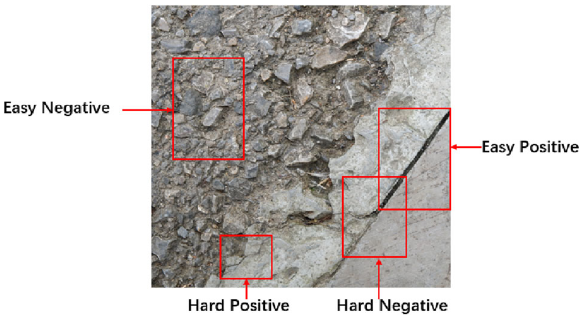
Fig. 15 Schematic diagram of various samples